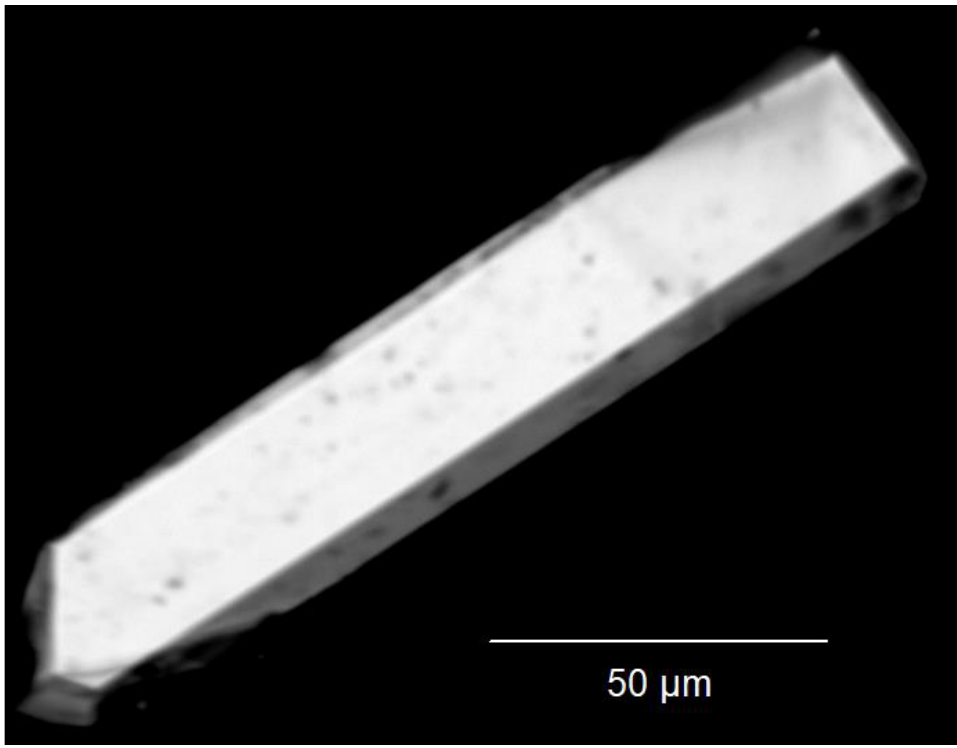
Figure 2. Scanning electron micrograph (SEM) of the measured, in this case bar-shaped, single crystal of Tm 3 F[Si 3 O 10 ].